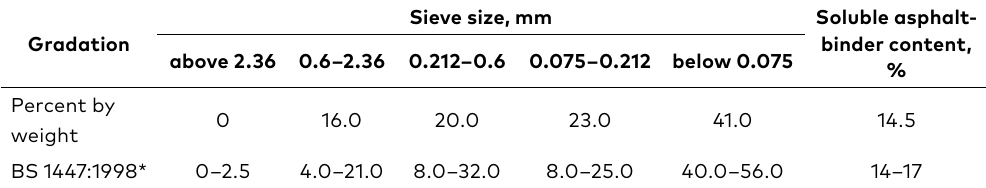
Table 3. Gradation of fine aggregate and the soluble asphalt-binder content Sieve size, mm Soluble Gradation